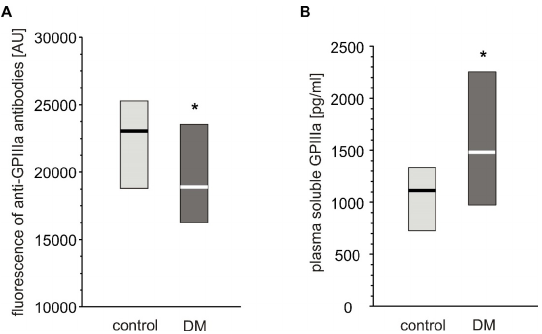
Figure 3. Level of GPIIIa on platelet surface and in blood plasma from type 2 diabetic patients and control subjects. Results presented as median (vertical line) and interquartile range box. Expression of GPIIIa on platelets surface was assayed by flow cytometry ( n = 33) ( A ); concentration of soluble GPIIIa in plasma was determined by ELISA (n control = 36, n DM = 41). Mean age 53.9 ± 8.0 (control) vs. 57.3 ± 7.7 (DM) (mean ± SD) ( B ). More experimental details are given in the Materials and Methods section. The asterisk denotes the particular significances estimated with non-paired Student’s t-test: GPIIIa expression: * p < 0.05, control > DM; plasma-soluble GPIIIa concentration: p < 0.01, control < DM. Table 1 GPIIIa-positive small and large microparticles in blood of non-diabetic individuals and type 2 diabetic patients. Non-diabetic ( n = 25) Type 2 diabetic ( n = 29) all microparticles (µL − 1 ) small microparticles < 0.5 µm (µL − 1 )